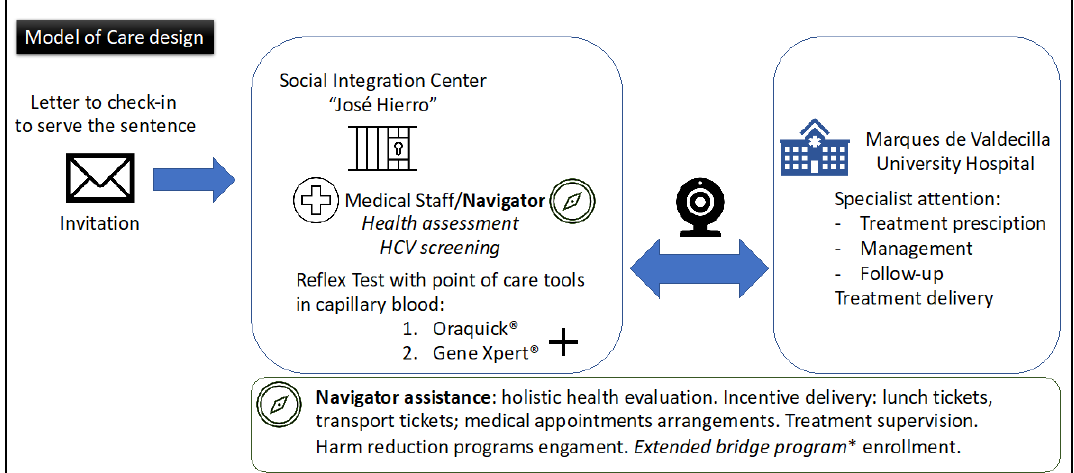
Figure 2. Model of care design. Social Integration Center “José Hierro” (SIC)—it is the location where these subjects check in to serve these sentences. Extended Bridge program*: health program supported by the government included in a global plan to attend chronic diseases, this one is focused on severe mental illness to serve sentences with alternative measures.